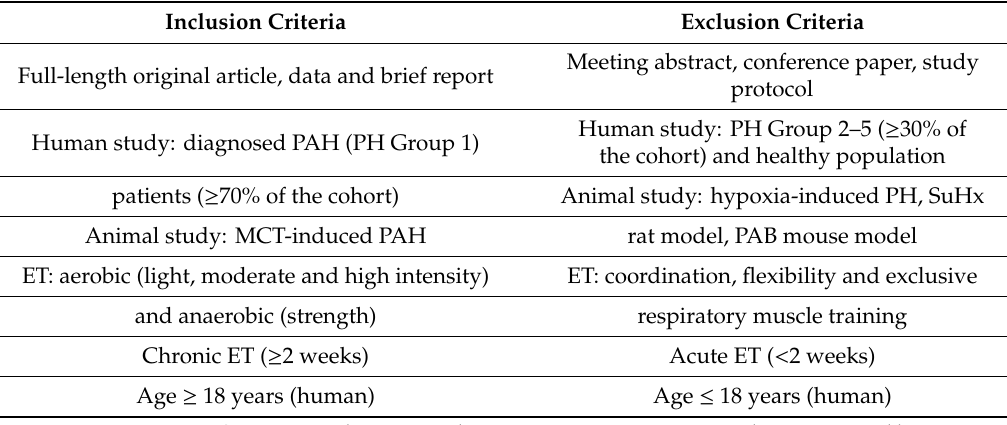
Table 2. Eligibility criteria for study inclusion and